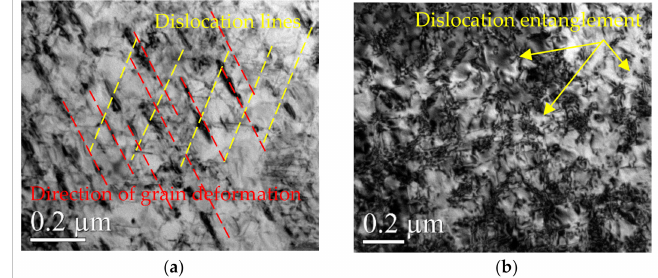
Figure 7. The change of the γ phase shocked by LSP at di ff erent temperatures: ( a ) 25 ◦ C, ( b ) 200 ◦ C.